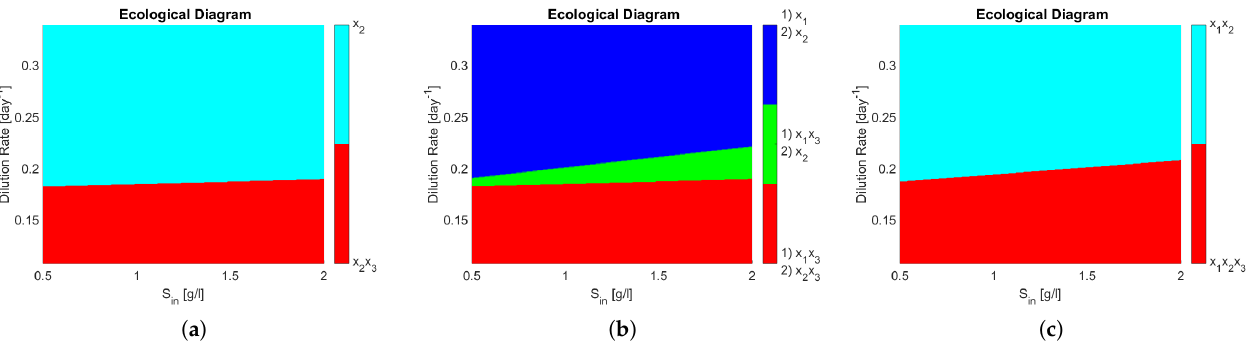
Figure 4. Ecological diagrams (ED). The different zones represent the combination of surviving species in the steady state. PN takes place when neither x 3 nor x 4 are present. CN takes place if x 3 or x 4 are present. ( a ) ED from interaction matrix on Figure 3a. ( b ) ED from interaction matrix on Figure 3b. In the legend (1) and (2) represent the two different stable equilibria in each zone. ( c ) ED from interaction matrix on Figure 3c. Note that in ( b ) two stable equilibria exist for each